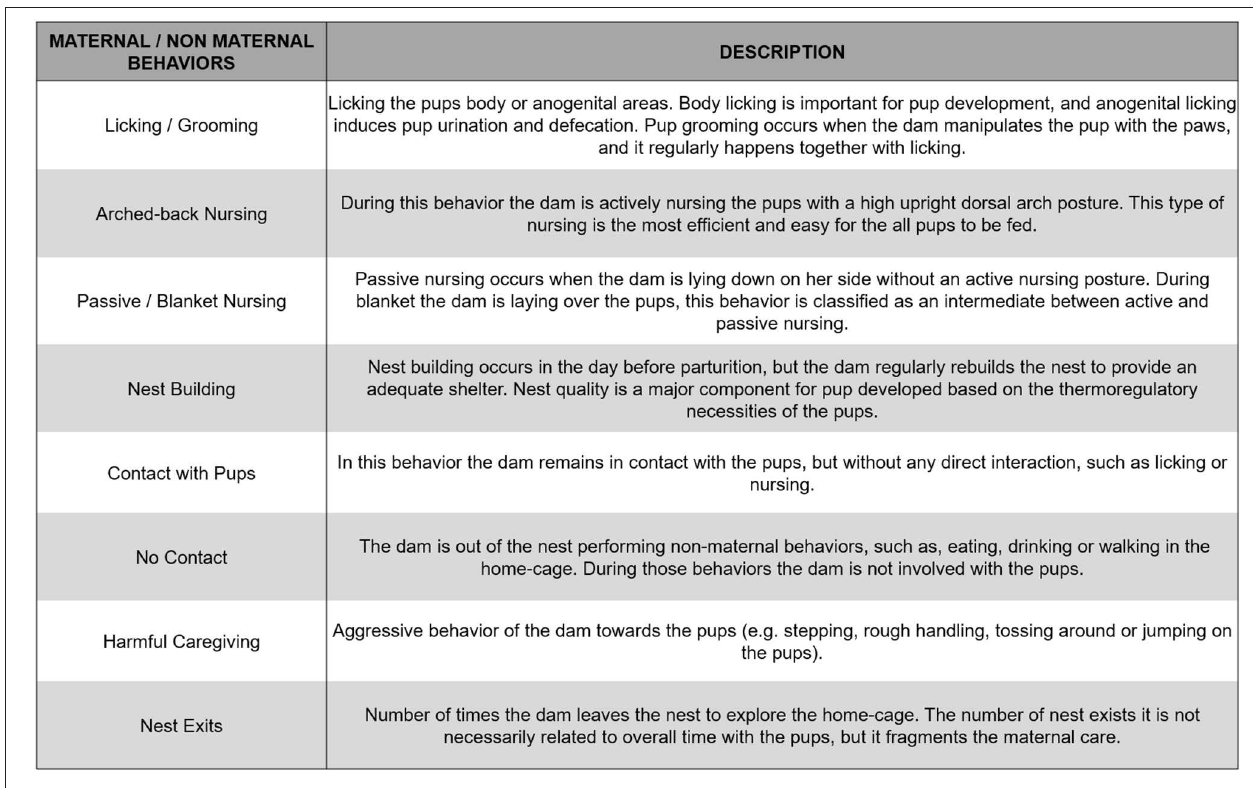
FIGURE 2 | Description of the behavioral categories included in the systematic